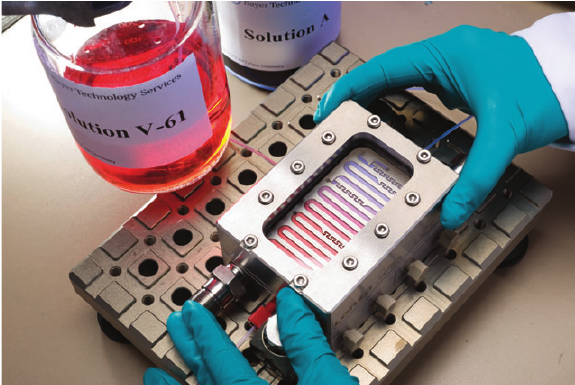
Figure 3 Lonza FlowPlate MicroReactor – Ready for use in Pharma research (and pre-clinical phases). © Bayer Technology Services